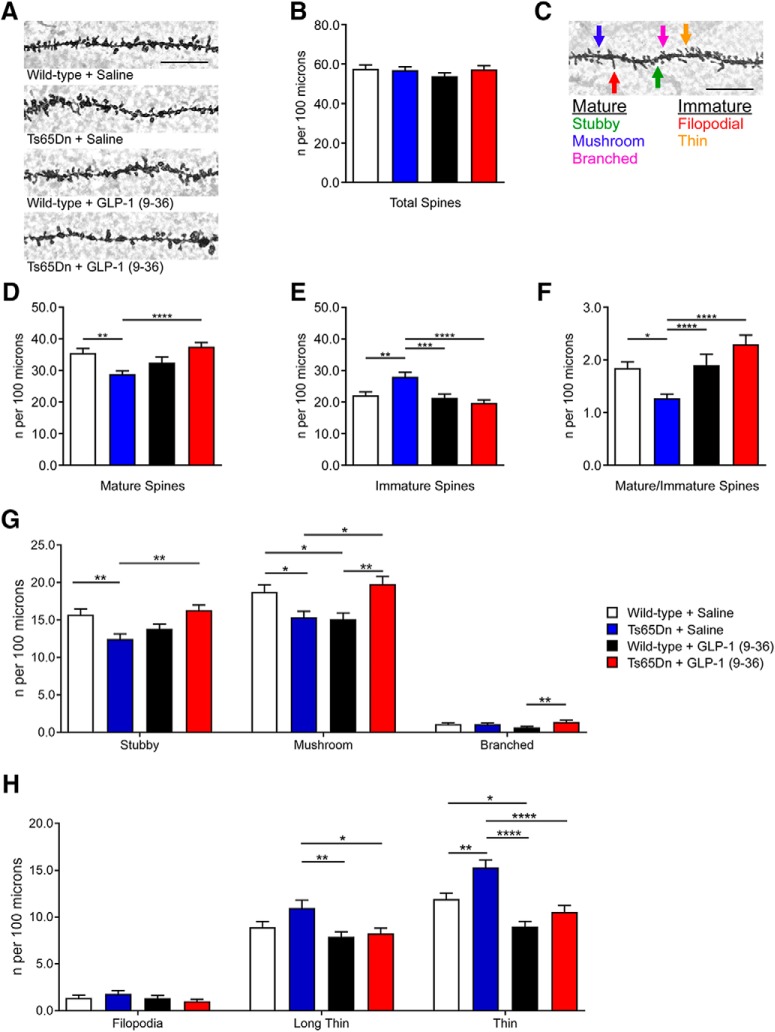
GLP-1 (9-36) treatment improves dendritic spine morphology of hippocampus in Ts65Dn mice. A, Representative images from Golgi-Cox stain of area CA1 dendritic spines (100×, scale bar, 12.5 μm). B, Total area CA1 dendritic spine density (counts per 100 μm) was unaltered among all experimental groups. C, Diagram depicting dendritic spine classification based on previous publication (100×, scale bar, 12.5 μm). D, Mature spine density (counts per 100 μm) was decreased in Ts65Dn mice compared with WT group, and was improved with treatment of GLP-1 (9-36). Stubby, mushroom, and branched spine types were classified as mature. E, Immature spine density (counts per 100 μm) was increased in Ts65Dn mice compared with WT group, and was restored with GLP-1 (9-36) treatment. Filopodial and thin type spies were classified as immature. F, Mature–immature spine ratio was reduced in Ts65Dn mice compared with WT group, and was restored with GLP-1 (9-36) treatment. G, Subclassification of mature spines. H, Subclassification of immature spines (WT+ Saline: n = 81 dendrites; Ts65Dn + Saline; n = 80 dendrites; WT+ GLP-1 (9-36): n = 51 dendrites: Ts65Dn + GLP-1 (9-36): n = 81 dendrites). *p < 0.05, **p < 0.01, ***p < 0.001, ****p < 0.0001; one-way ANOVA with Tukey’s posthoc test. Values represent mean ± SEM.